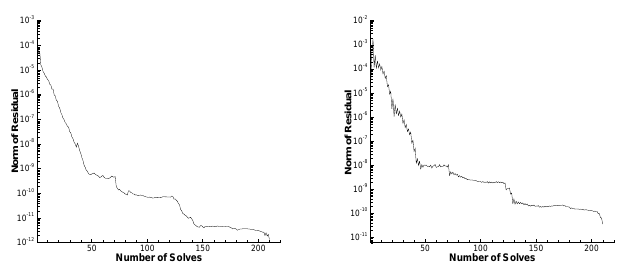
Figure 9. Nonlinear residual for Re = 100 ε = 0 . 2 . Outer cylinder on the left and inner cylinder on the right.